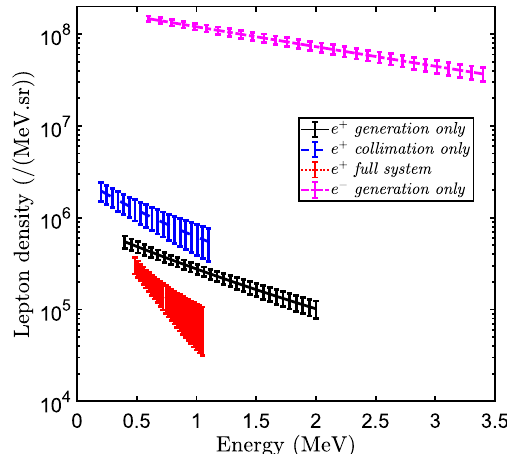
FIG. 3. Experimental positron spectra obtained using the full system (red dotted line), the quadrupole doublet but no second dipole (blue dashed line), and using no quadrupole and no second dipole (black solid line). The mean electron spectra escaping the solid target in that last configuration is also shown for comparison (dashed dotted magenta line). Error bars are the result of combining the typical on-shot small-scale fluctuations and the shot-to-shot variability.